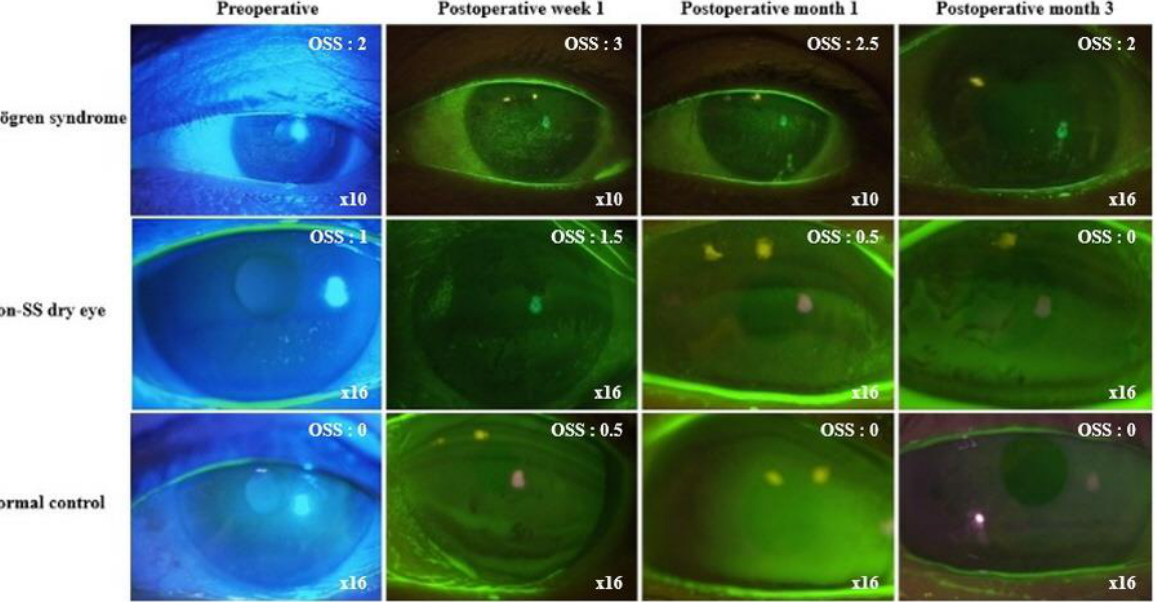
Figure 1. Representative slit-lamp findings in patients with Sjögren syndrome (SS), non-SS dry eye, and normal control before and after cataract surgery. Magnification of slit lamp photographs and ocular staining score (OSS) of each image are indicated. The SS patient showed a higher level of ocular staining score than the other two patients at every visit. Temporary exacerbation of corneal erosion was observed in all groups after cataract surgery. The SS patients had a longer recovery